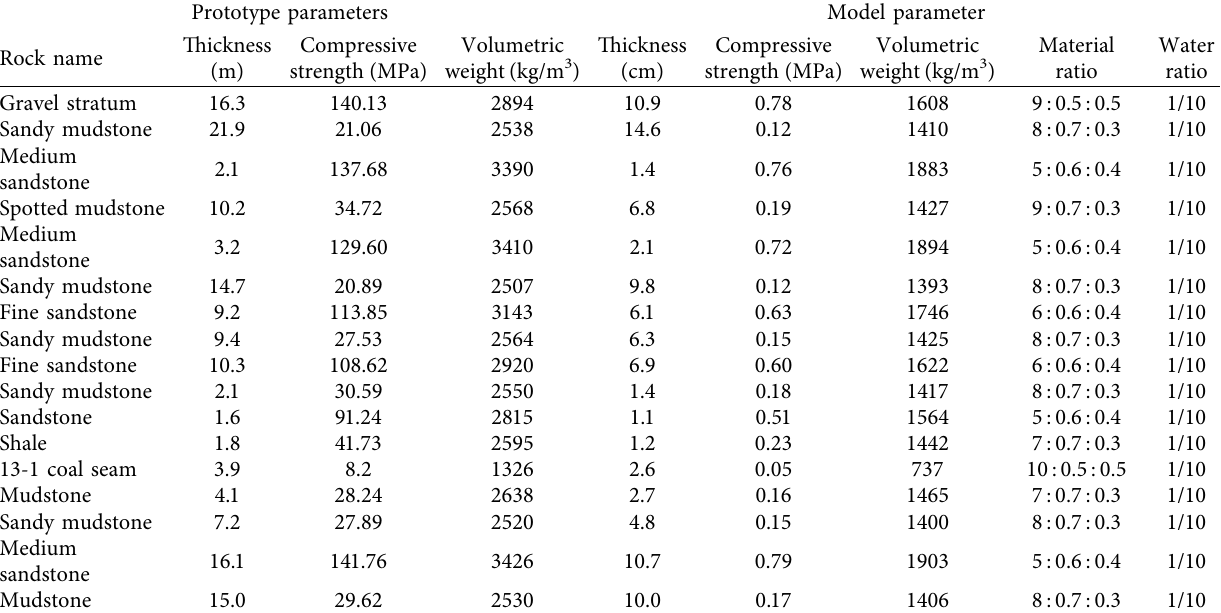
Table 1: The comparison table of the field conditions of working face and simulation parameter.